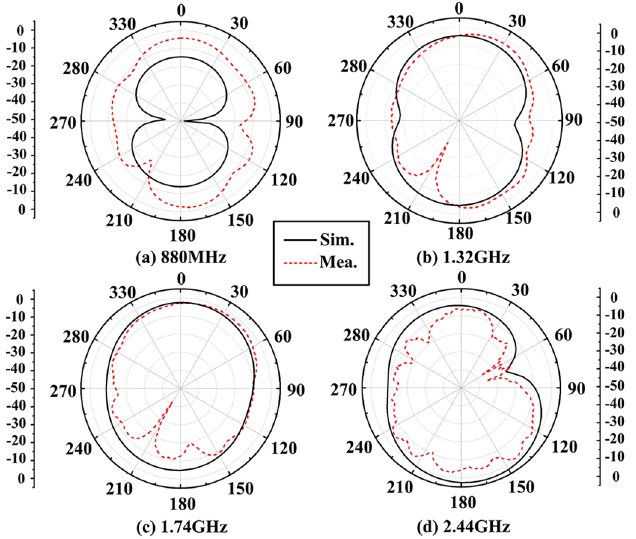
Fig. 6. Measured and simulated radiation patterns of proposed antenna.